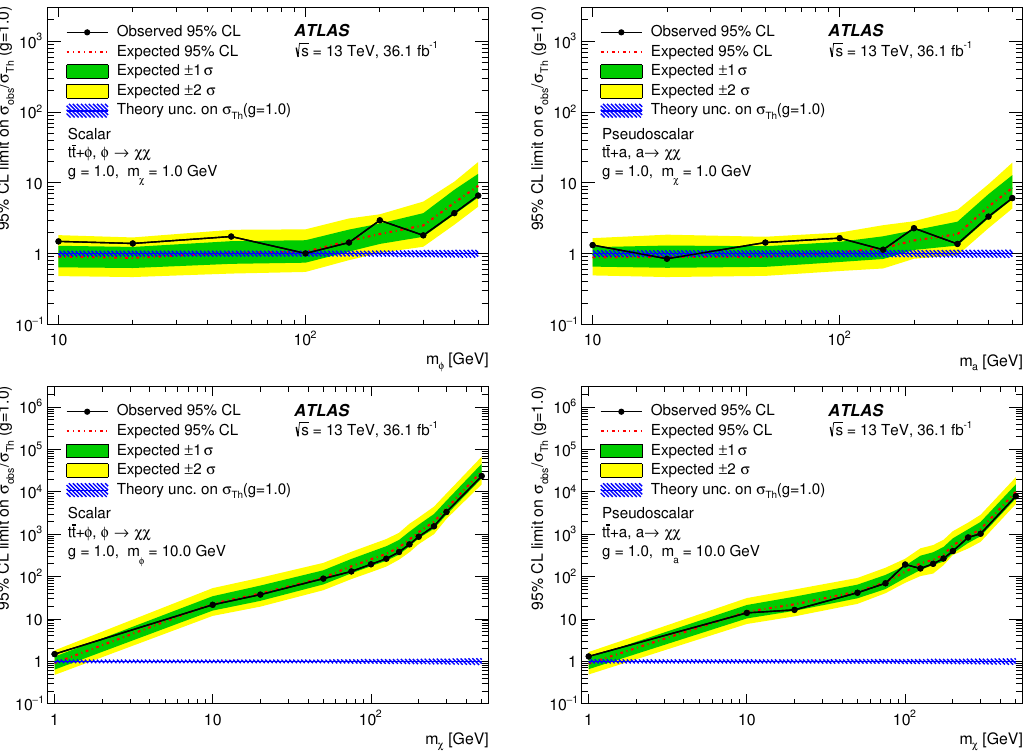
Figure 28 . Upper limit on the ratio of the DM production cross-section to the simpli(cid:12)ed model expectation under the hypothesis of (left) a scalar or (right) a pseudoscalar mediator. The limit is shown as a function of: (top) the mediator mass for a (cid:12)xed mass of the DM candidate of 1 GeV, or (bottom) the DM candidate mass for a (cid:12)xed mediator mass of 10 GeV. The coupling of the mediator to SM and DM particles is assumed to be g =